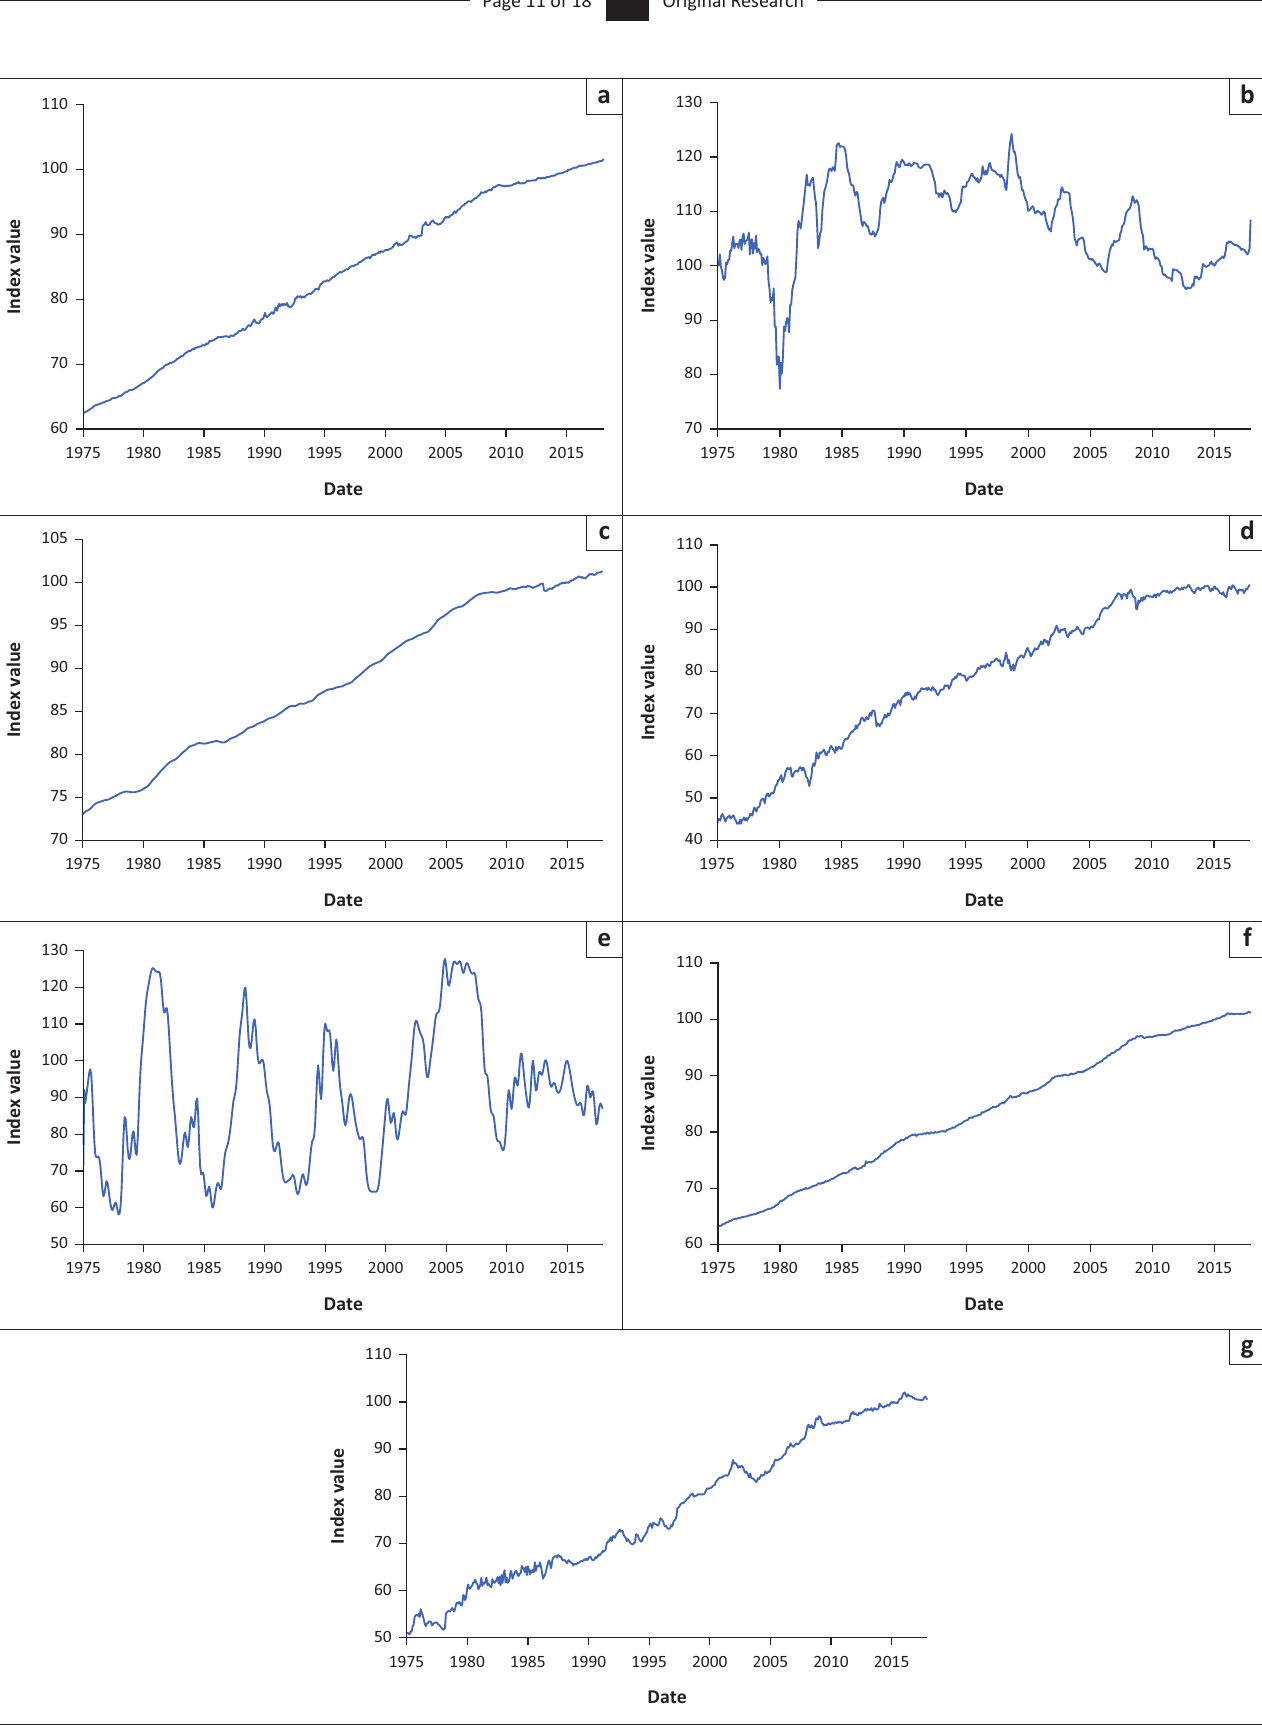
Source : Self-constructed in Eviews. FIGURE 2: Index plots of important South African financial sections. (a) credit index, (b) interest rate index, (c) house price index, (d) equity index, (e) confidence index, (f) balance sheet index, (g) foreign position